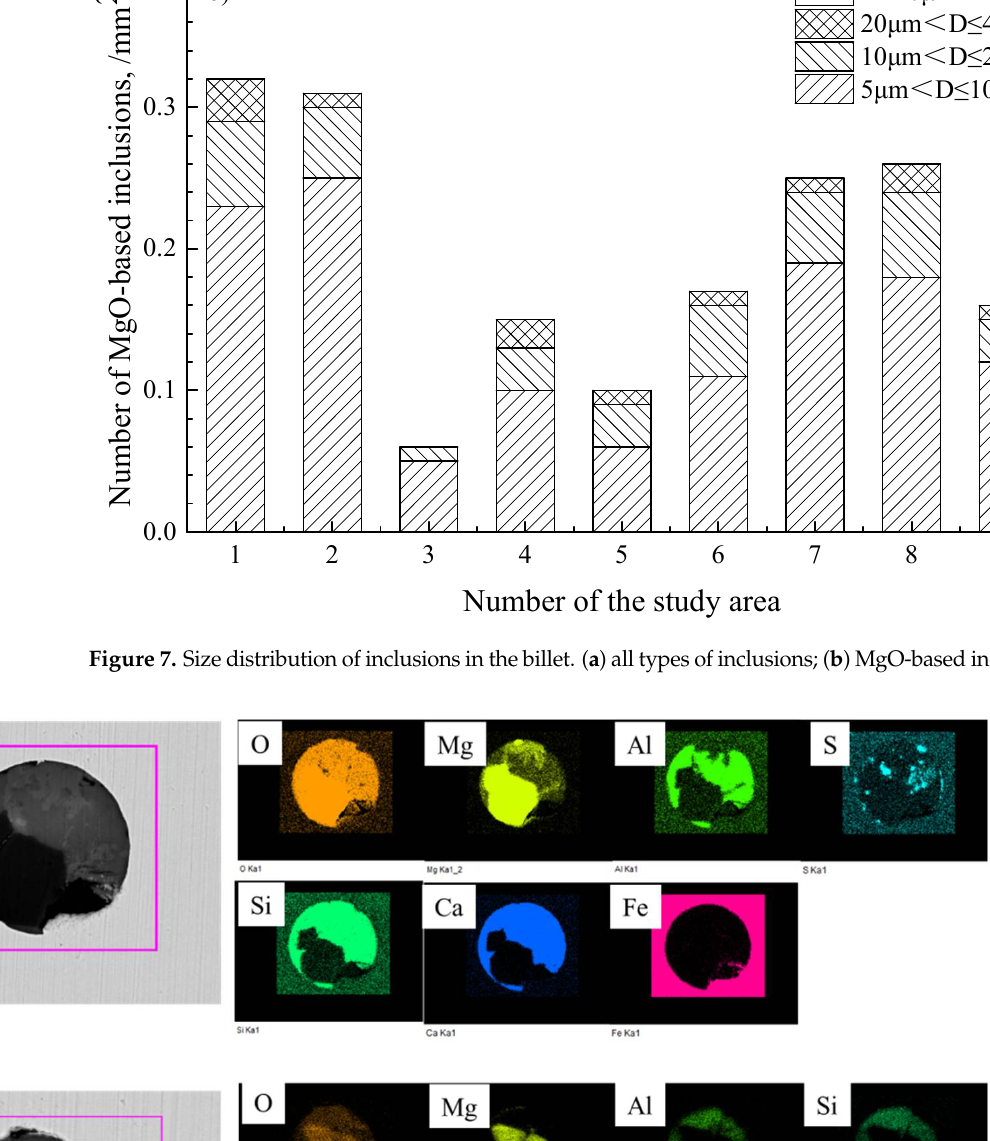
Figure 8. Morphology and composition of typical inclusions in billet.